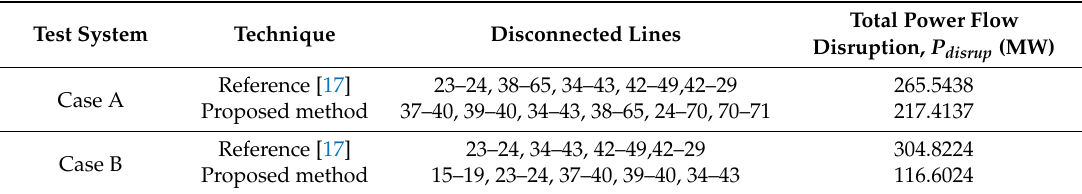
Table 8. The network splitting solution from this study and that of [17].